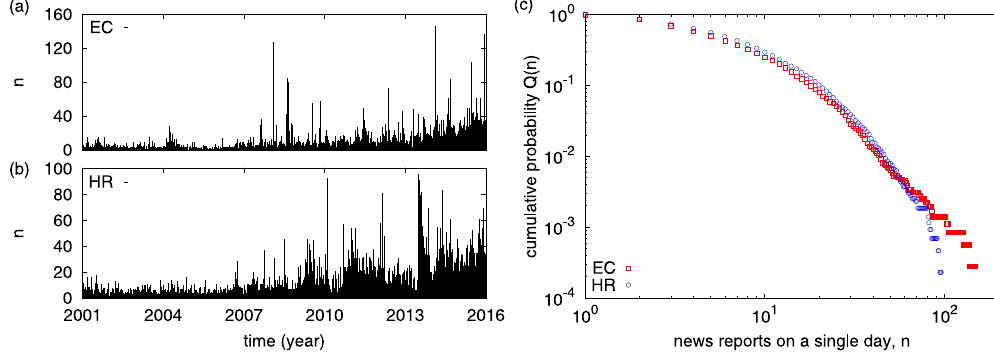
Figure 1. The time sequence of the number of events n reported daily for ( a ) EC, ( b ) HR during 2001–2015. ( c ) The cumulative probability (CCDF) Q ( n ) that n or more events are reported on a particular day. The data for EC seems to fit well to a power law for the largest values, with decay exponent around 2.54 ± 0.03, HR fits well to a stretched exponential (exp[ − an b ] with a = 0.44 ± 0.12 and b = 0.62 ±